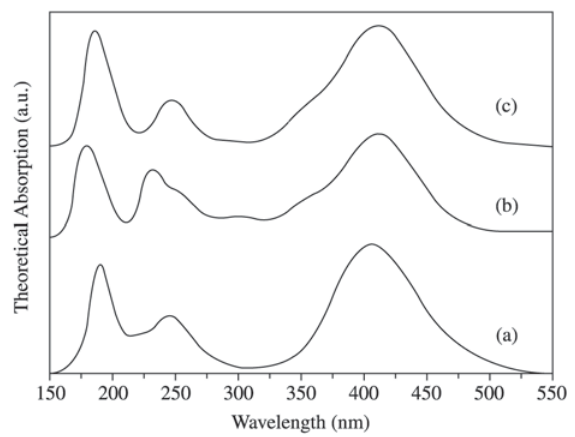
Figure 5. Theoretical absorption spectra. (a) CV + / CV + , (b) MG + / MG + and (c) CV + /MG + dimers in parallel structure by INDO/S-CI (absorption spectra) using the semiempirical method calculated for optimized